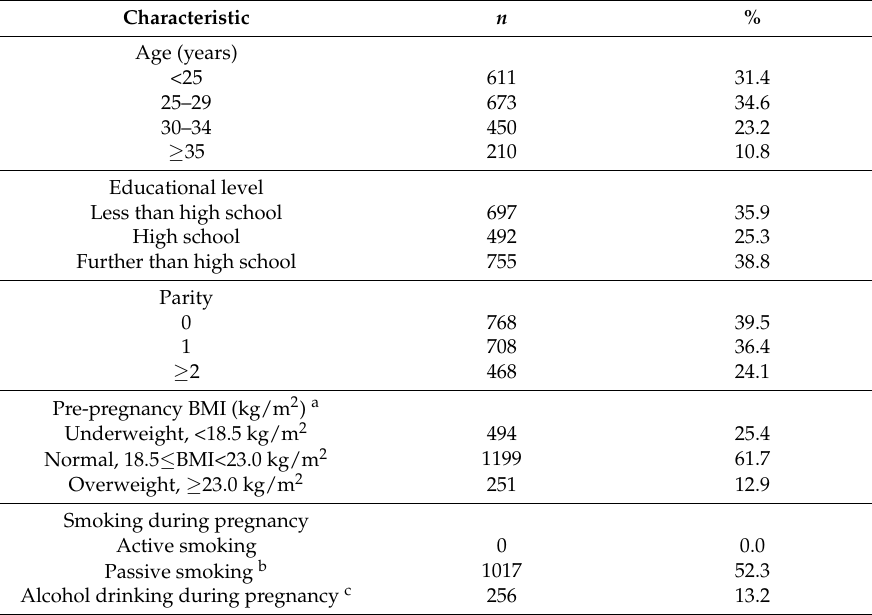
BMI: Body mass index. a Based on cut-off for Asian population [40]. b Defined as any exposure to smoking at home or workplaces during pregnancy. c Defined as drinking any alcohol during